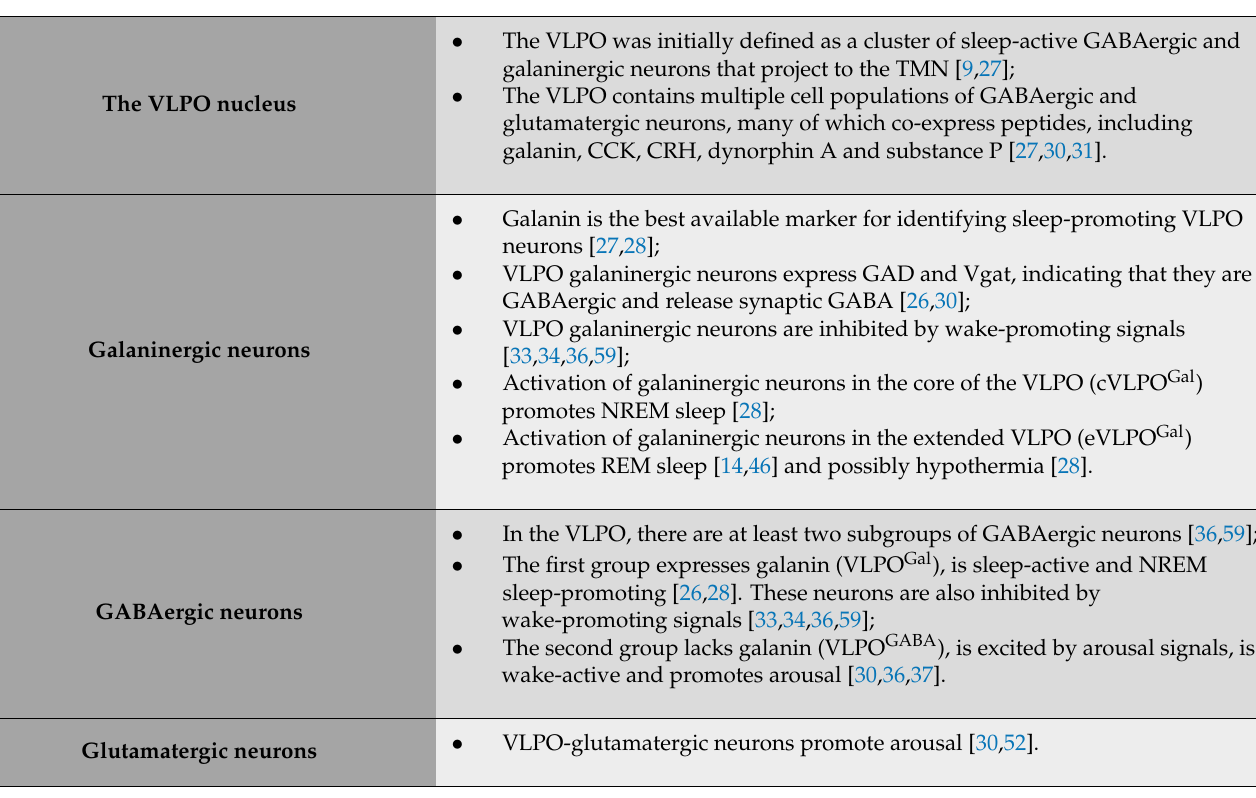
Table 2. Cellular anatomy of the VLPO: selected key